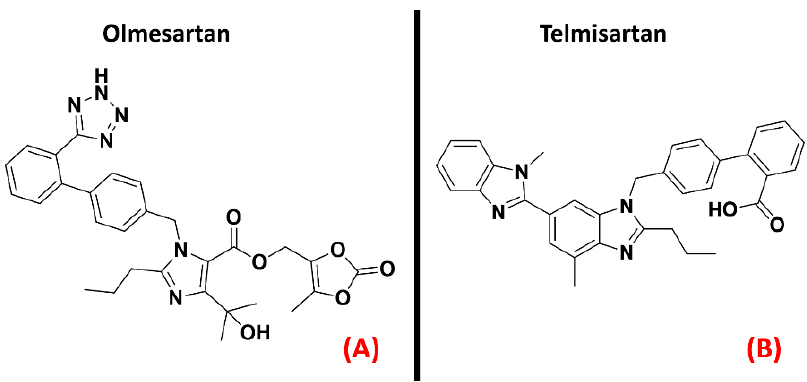
Figure 8. The chemical structures of the AT 1 antagonists Olmesartan ( A ) and Telmisartan ( B ). Summing up the information obtainable from the literature, AT 1 inhibition could be examined as a potential new therapeutic method of fighting ALS conditions. Both AT 1 and AT 2 receptors are represented in Figure 9 below.